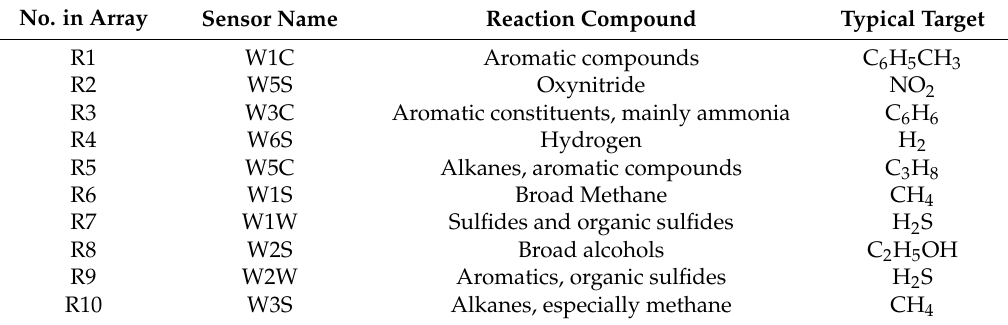
Table 1. Performance of the sensor arrays of the PEN3 electronic